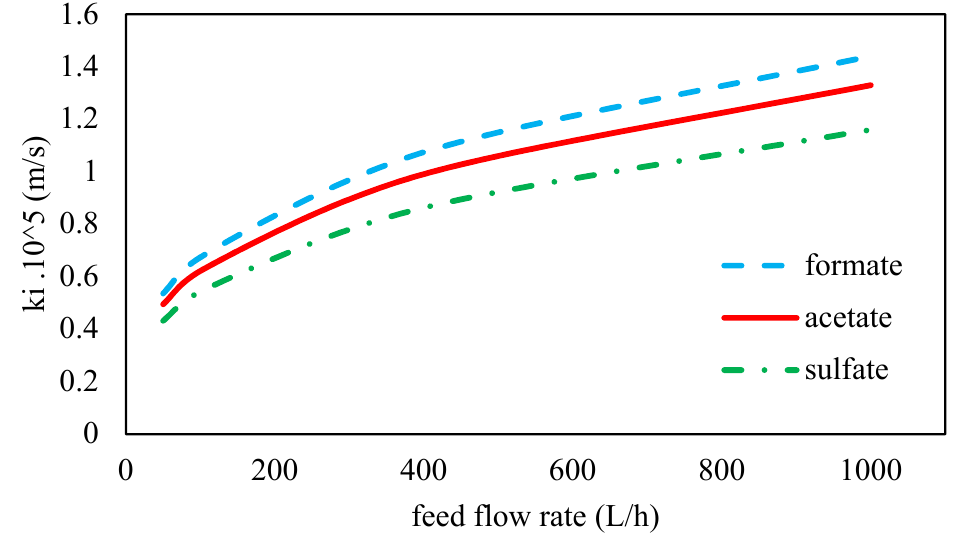
Figure 7. The mass transfer coefficient as a function of feed flow rate for different ions in 45 wt. % MDEA solution at 70 bar and 35 ° C.